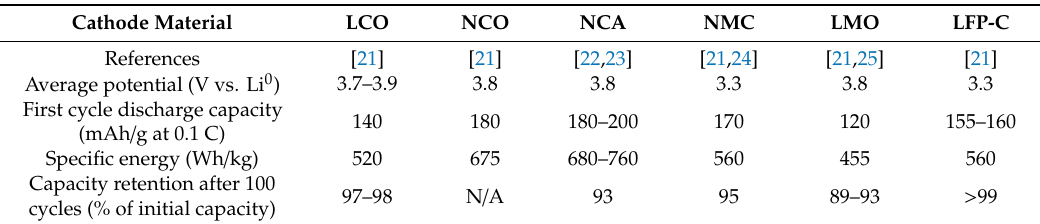
Table 1. Electrochemical properties of six of the most important types of Li-ion batteries; here, LCO, NCO, NCA, NMC, LMO, and LFP-C are lithium-cobalt oxide, lithium-nickel-cobalt oxide, lithium-nickel-aluminum oxide, lithium-nickel-manganese-cobalt oxide, lithium-manganese-oxide, and carbon-coated lithium-iron-phosphate,